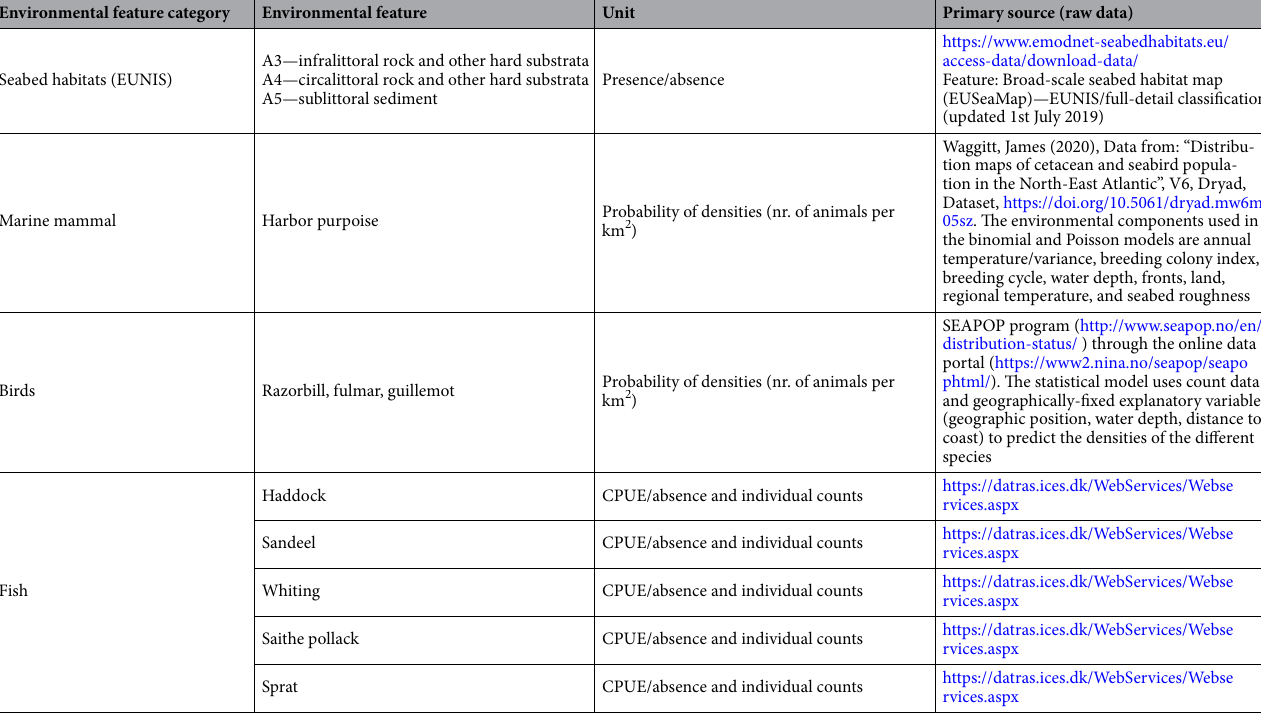
Table 1. Primary sources for the environmental component data